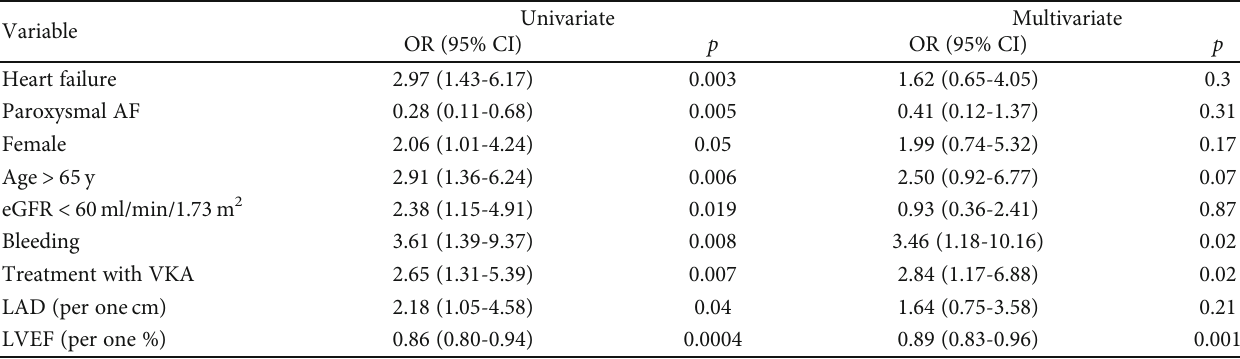
Table 4: The results of univariate and multivariate logistic